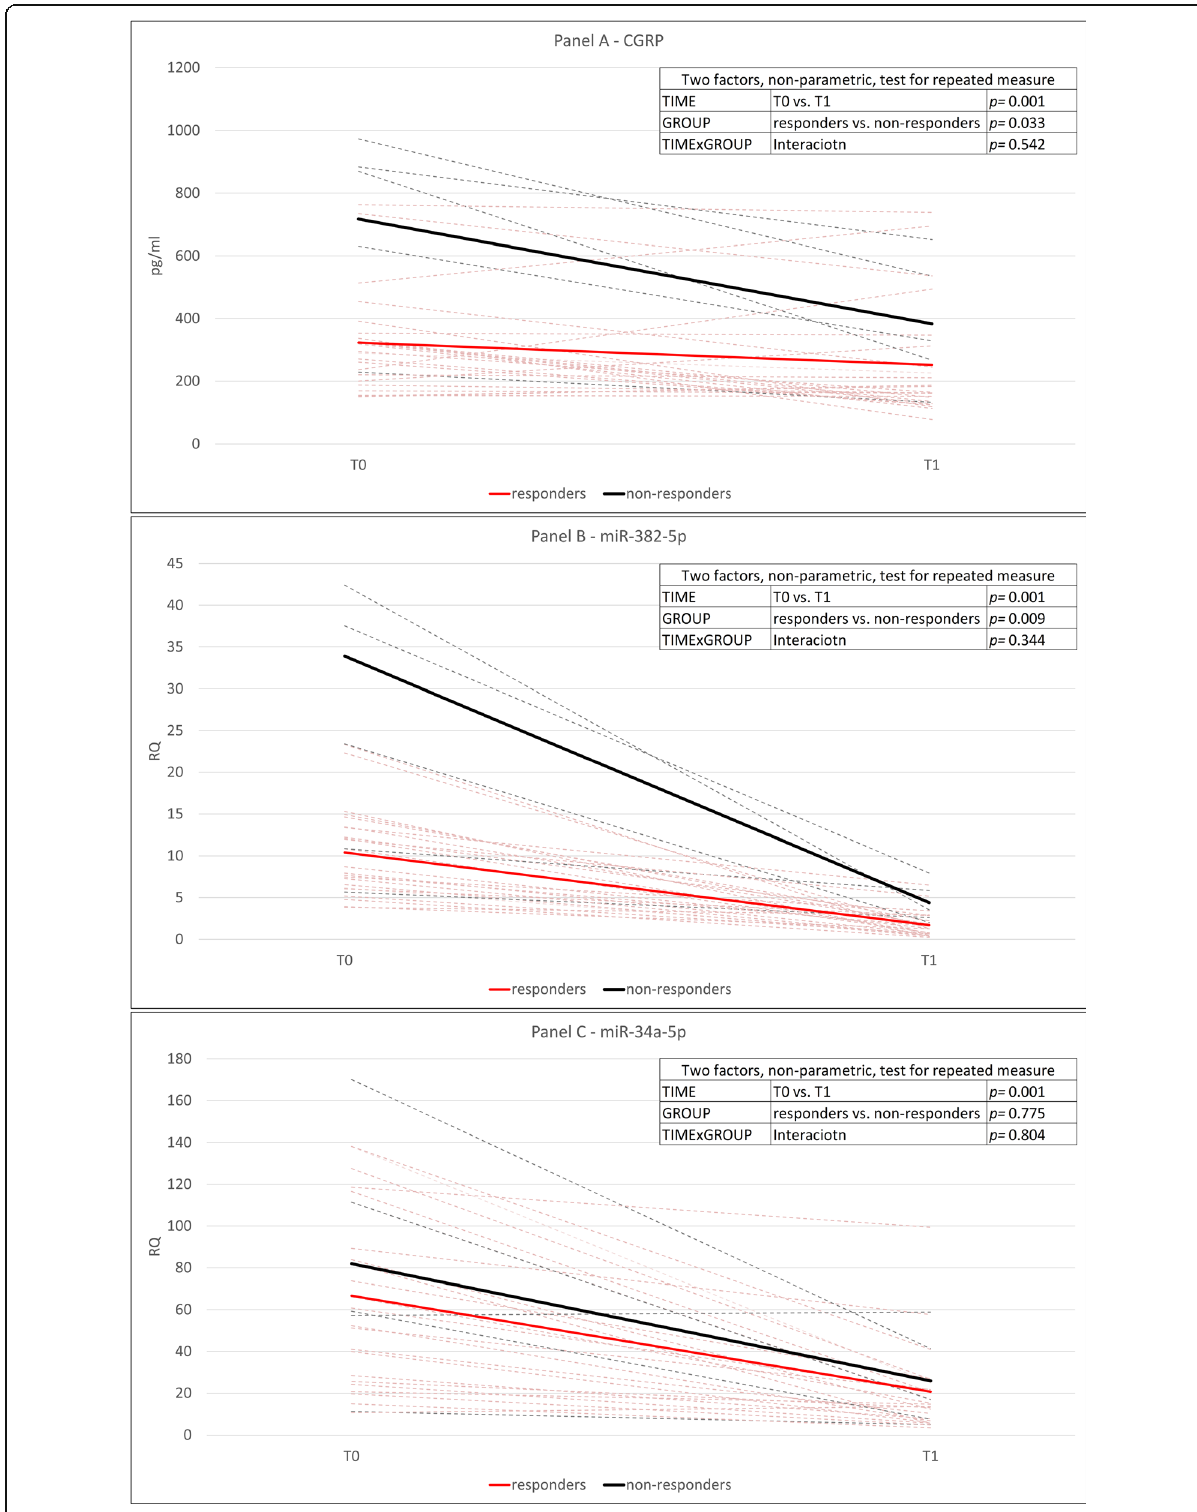
Fig. 2 (See legend on next